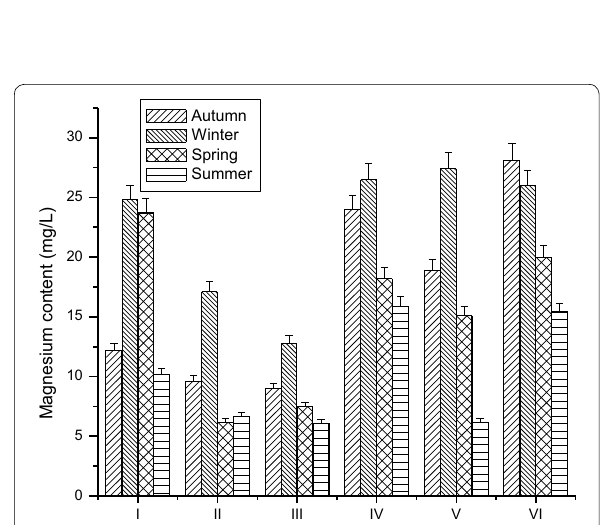
Fig. 12 Spatial and temporal variations of magnesium content (mg/L) in Hokersar wetland during September 2012–August